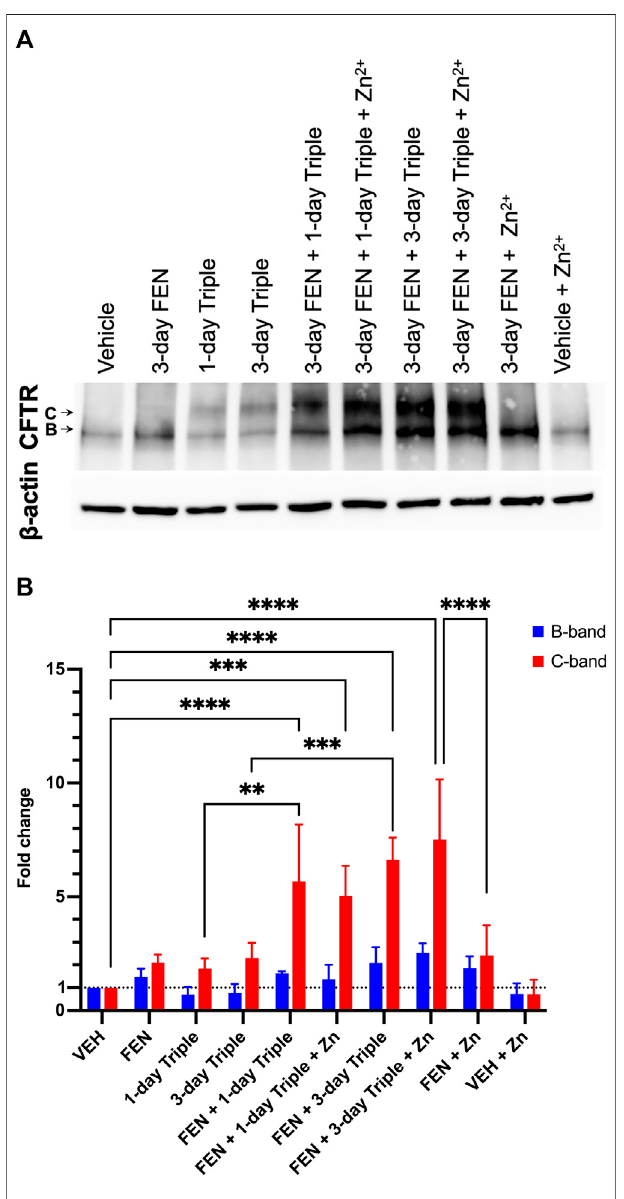
FIGURE 9 | Total CFTR protein level in CFBE41o-(F508del) cell line. Western blot analysis (A) and quanti fi cation of three replicates (B) . The CFTR protein has two glycosylated forms, the B band which is ~131 kDa, or the C band at ~160 kDa. For both B and C bands, the greatest fold change can be seen upon combinatory treatment of FEN, Triple therapy, and Zinc. Two-way ANOVA with Sidak correction, where *** p < 0.001, **** p <